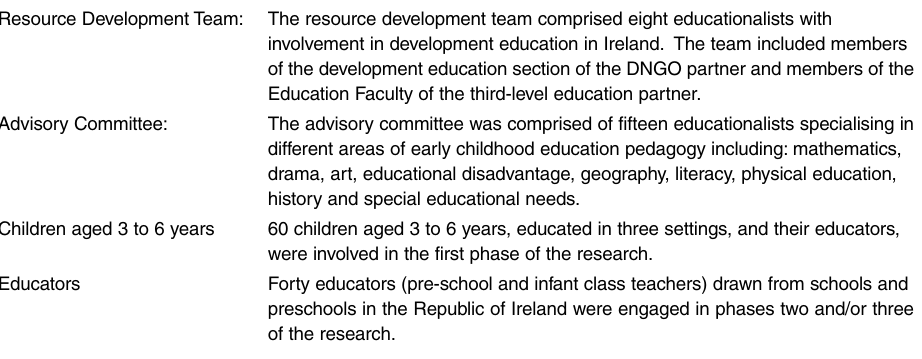
Table 1: Groups involved in the research and resource development process